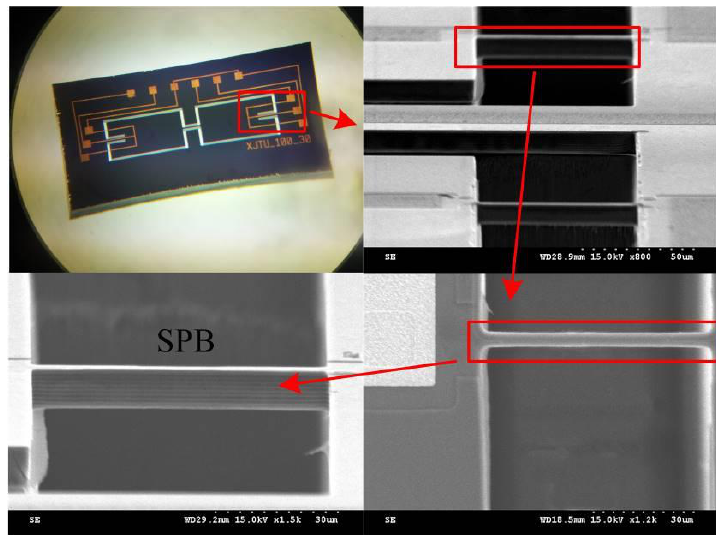
Figure 7. The micrograph of the fabricated chip.